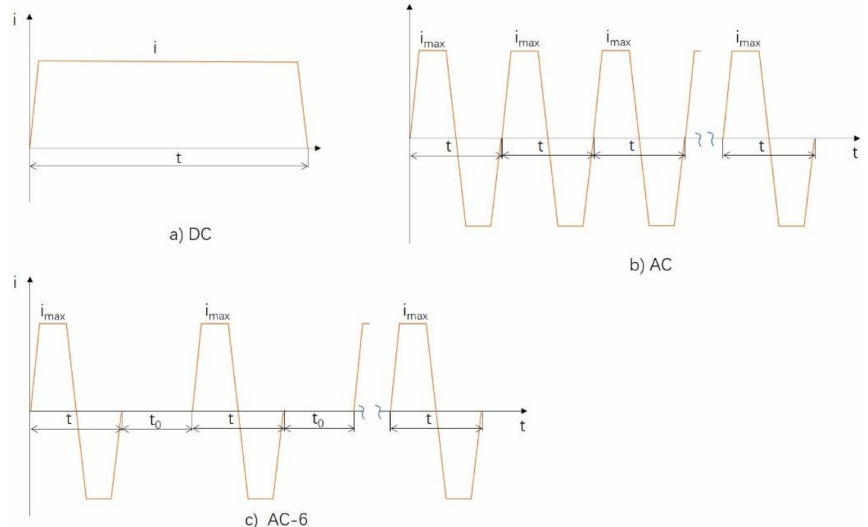
Figure 10. Current modes applied in the present investigation: ( a ) DC: direct current, ( b ) AC: mid-frequency alternating current, ( c ) AC-6: mid-frequency alternating current with a 6 ms cooling interval every other cycle.